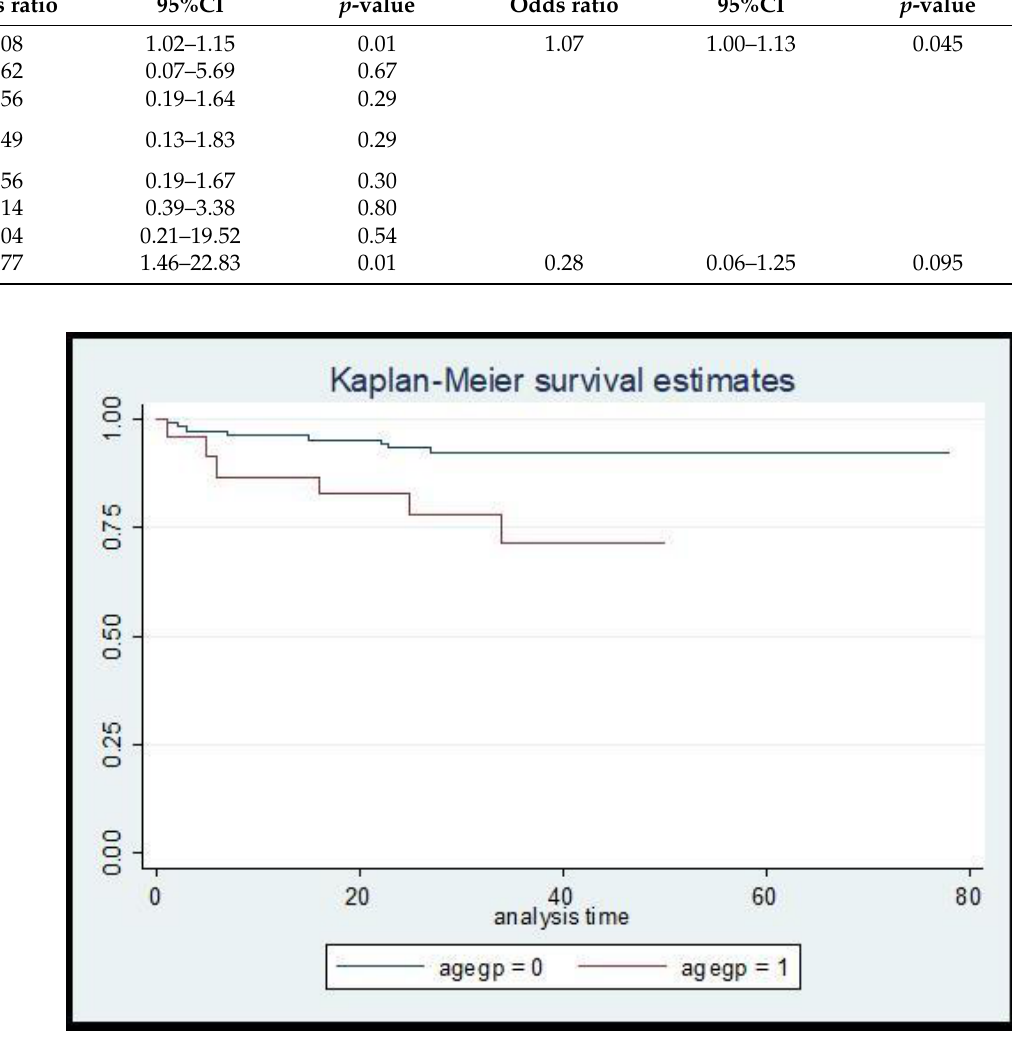
Figure 1. Survival curve for stroke recurrence among age ≤ 60 years vs. > 60 years.